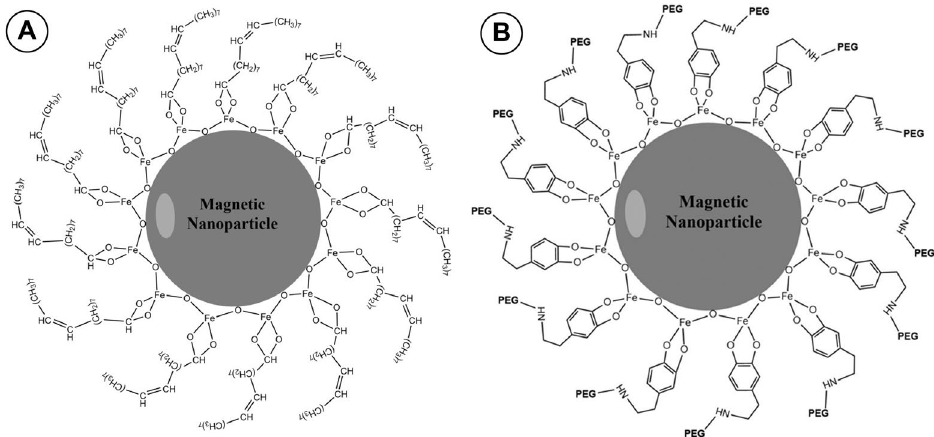
Figure 3. Schematic illustrations of ( A ) the structure of the oleic acid-coated MNP and ( B ) the PEG- covered MNP after the displacement of the oleate in the phase transfer process. PEG-covered MNP after the displacement of the oleate in the phase transfer process.